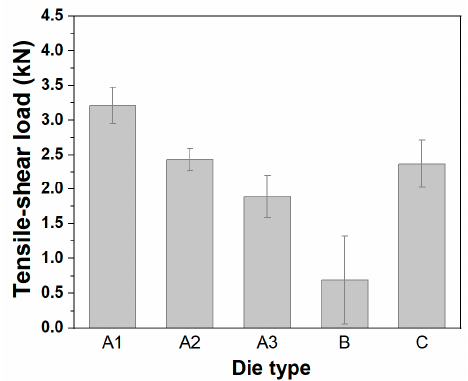
Figure 8. Tensile–shear loads for SPR joint of vibration-damping steel (top) and Al5052-H32 (bottom) with respect to SPR die type.